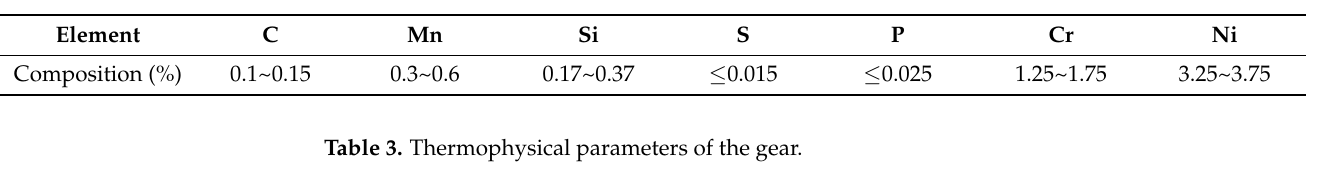
Table 2. Composition of 12Cr2Ni4A alloy steel.